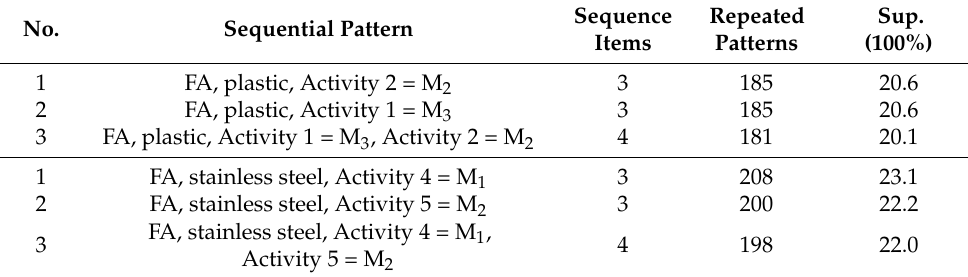
Table 15. Frequent sequential patterns for machine type = FA and material of drum.